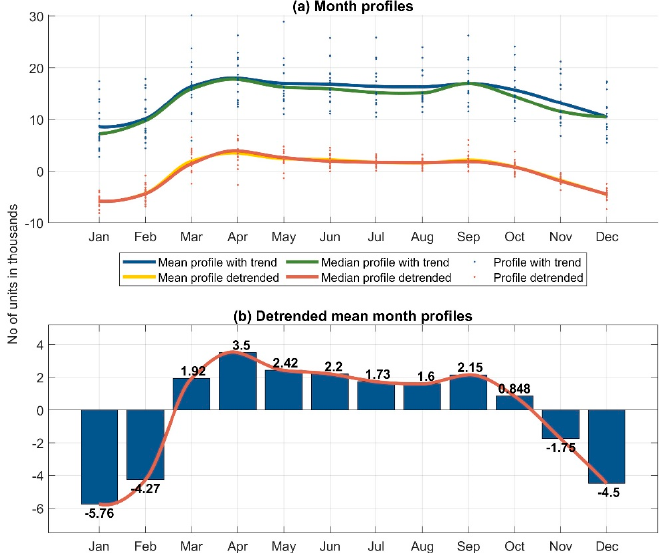
Figure 4. Averaged annual profile. Housing units whose construction has begun—total (Source: own compilation based on data from CSO).